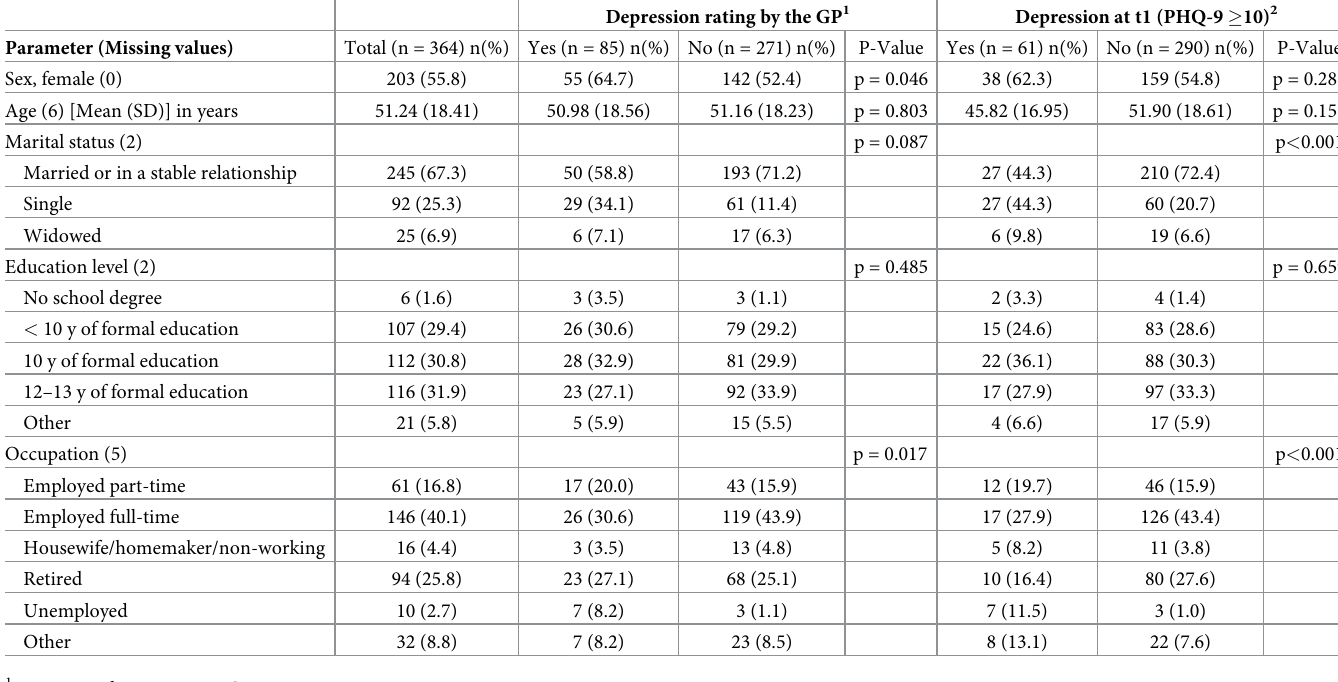
Table 1. Baseline characteristics